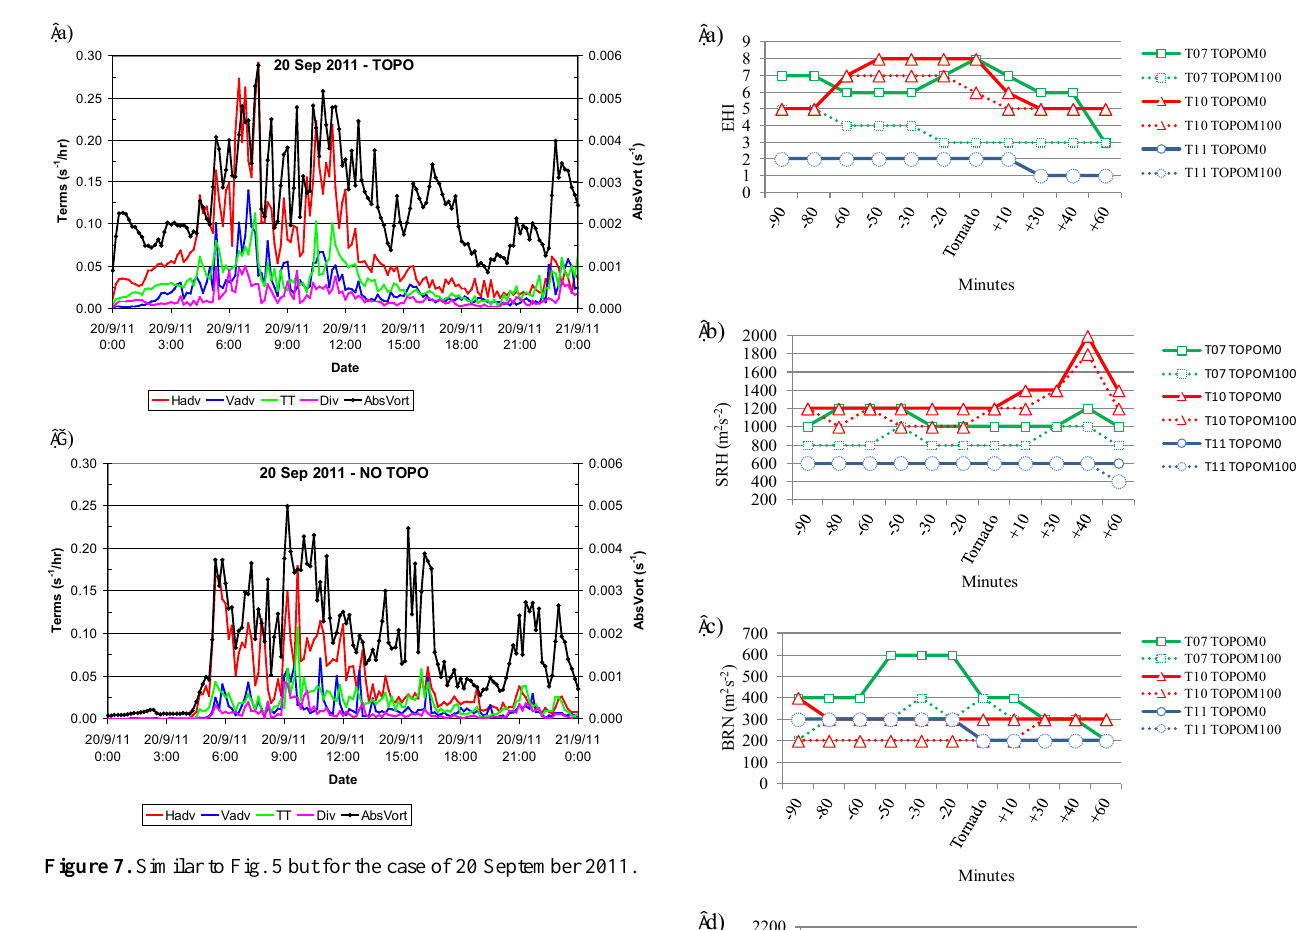
less than 15 km to the south), while 30 min after tornadoge- nesis EHI reduces to 6 (Fig. 8a). In contrast to TOPOM0, TOPOM100 (Fig. 8a, dotted green line with squares) EHI analysis depicts a gradually reduction of EHI values (from 5 to 3) prior to the time of tornadogenesis, documenting the influence of topography. During T10 numerical simula- tions with TOPOM0 (Fig. 8a, solid red line with triangles) and TOPOM100 (Fig. 8a, dotted red line with triangles), EHI analysis presents significant high values (EHI > 5) for both simulation sets. More specifically, the TOPOM0 exper- iment shows a gradual increase of the EHI value (from 5 to 8, 80 min prior to tornadogenesis) (Fig. 8a). Figure 9b de- picts this value too close to the tornadogenesis location (less than 10 km to the WSW), while after tornado formation the EHI declines to 5. The EHI analysis of T10 TOPOM100 experiment presents lower values (compared to TOPOM0) that started reducing prior to tornadogenesis. Regarding the T11 (a coastal tornado event) TOPOM0 (Fig. 8a, solid blue line with circles) and TOPOM100 (Fig. 8a, dotted blue line with circles) numerical simulations, EHI analysis remains identical, suggesting that topography did not influenced EHI. The spatial distribution of EHI in T11 TOPOM0 experiment shows a value of EHI > 2, 30 km SE of tornado location (Fig. 9c).